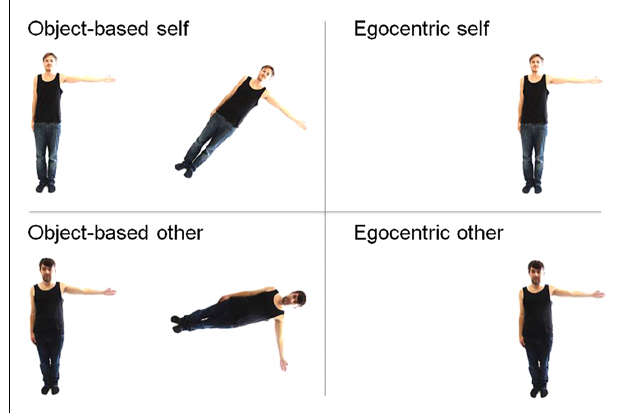
FIGURE 1 | Examples of the stimuli used for the different conditions. Top stimuli show pictures of participants’ own body, whereas bottom stimuli depict gender-matched other’s body. Left: sample stimuli used in the same–different object-based transformation task, for disparities of 45 ◦ (top) and 90 ◦ (bottom). Right: stimuli used in the egocentric transformation task, where participants were asked to judge whether the depicted figure has their left or right arm